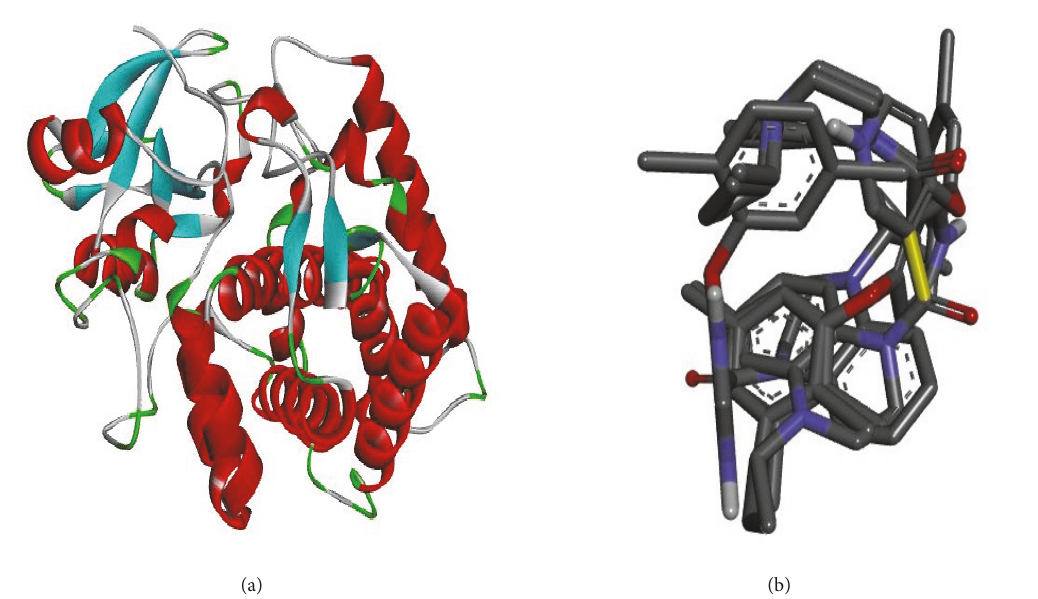
Figure 1: (a) Prepared structure of Mtb CYP121. (b) 3D structures of the prepared